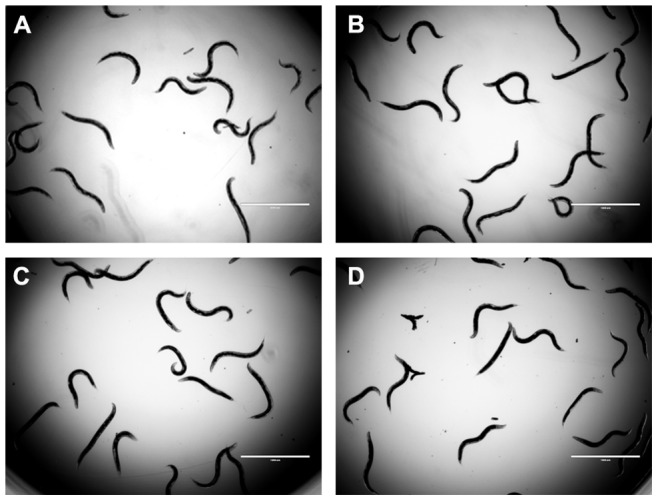
TET shows no toxicity on uninfected C. elegans glp-4; sek-1 nematodes.
C. elegans glp-4; sek-1 nematodes were pipetted into 12-well plates that contained different concentrations of TET, incubated at 25°C, and observed daily. On day 2, the worms were photographed. (A) 32 mg/L TET; (B) 64 mg/L TET; (C) 128 mg/L TET; (D) Treatment free group with the solvent DMSO added.